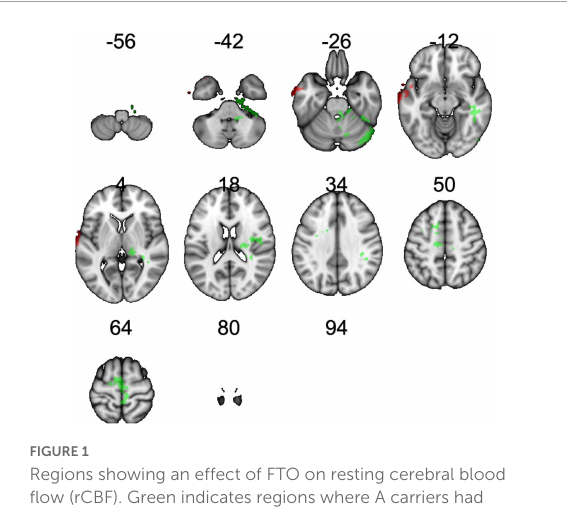
FIGURE1 Regions showing an effect of FTO on resting cerebral blood flow (rCBF). Green indicates regions where A carriers had greater rCBF than TT homozygotes (A carrier > T/T contrast), and red indicates regions showing greater perfusion in TT homozygotes than A carriers (T/T > A carrier contrast). Results were corrected for multiple comparisons. It was determined that contiguous clusters ≥ 293 voxels and z -values > 2.3 survived a threshold of p <